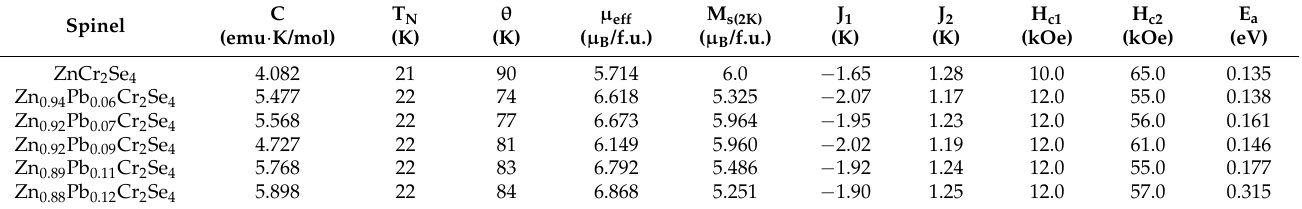
Figure 6. Electrical conductivity (ln σ ) vs. reciprocal temperature (10 3 /T) for ZnCr 2 Se 4 single crystals doped with Pb 2+ ions having contents of 0.06, 0.07, 0.09, 0.11, and 0.12. Table 5. Magnetic parameters of Zn 1 − x Pb x Cr 2 Se 4 single crystals recorded in an internal oscillating magnetic field H ac = 1 Oe with an internal frequency f = 120 Hz and with a zero external static magnetic field: C is the Curie constant; T N and θ are the N é el and Curie–Weiss temperatures, respectively; µ eff is the effective magnetic moment; J 1 and J 2 are the super-exchange integrals for the first two coordination spheres. H c1 and H c2 are the critical fields measured at the static magnetic field up to 70 kOe. E a is the energy activation measured in the temperature range of 300–400 K. Experimental data for the ZnCr 2 Se 4 matrix were taken from Refs. [1,21,22,31] for